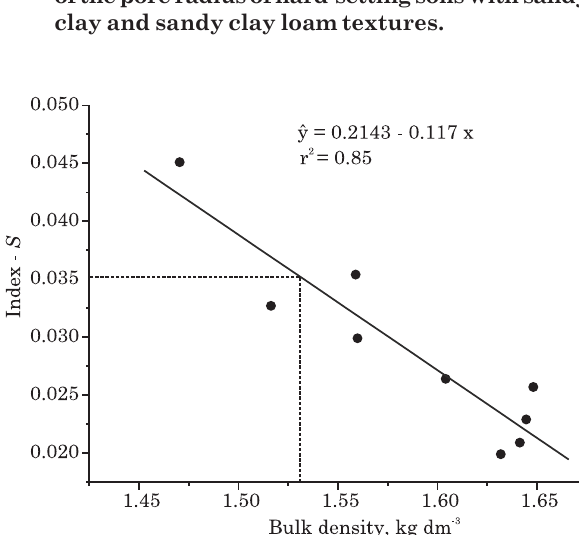
Figure 5. Index S values related to soil bulk density of hard-setting soils with sandy clay and sandy clay loam textures. The dashed line shows the S = 0.035 and the corresponding value of bulk density.